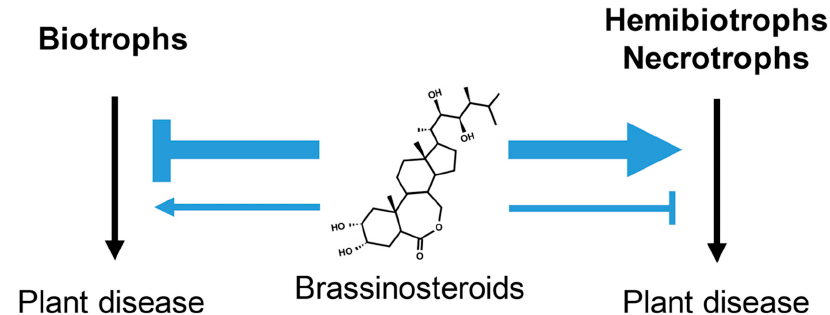
Figure 2. Brassinosteroids (BRs) modulate plant interactions with all three types of trophic pathogens; however, they appear to induce resistance to most biotrophs, but susceptibility to most necrotrophs and hemibiotrophs. The black arrows indicate induction of plant disease by different types of pathogens. The blue arrows and T-shaped lines signify promoting and inhibitory effects of BRs on pathogen-induced disease, respectively. The thickness of each arrow or line is proportional to the strength of BRs in the denoted